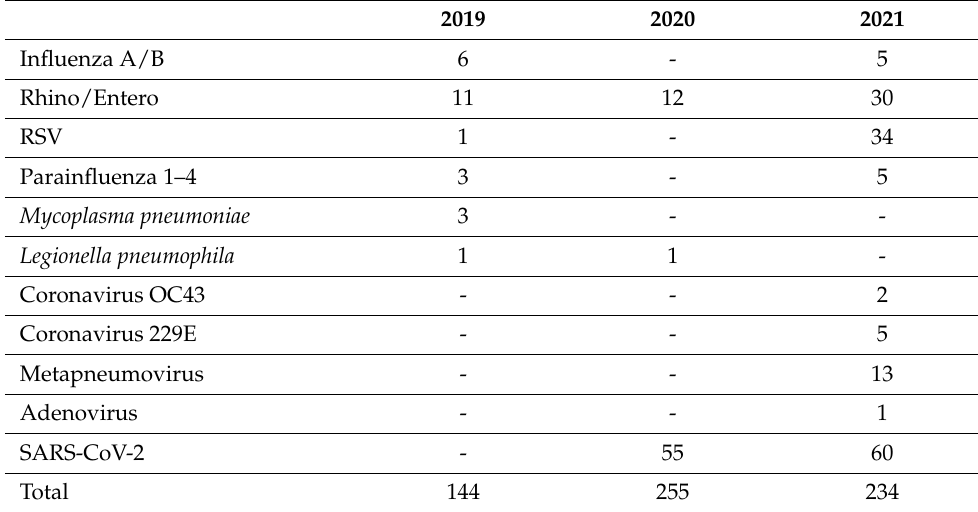
Table 3. List of CRPs detected in positive NPSs in fall of the last three